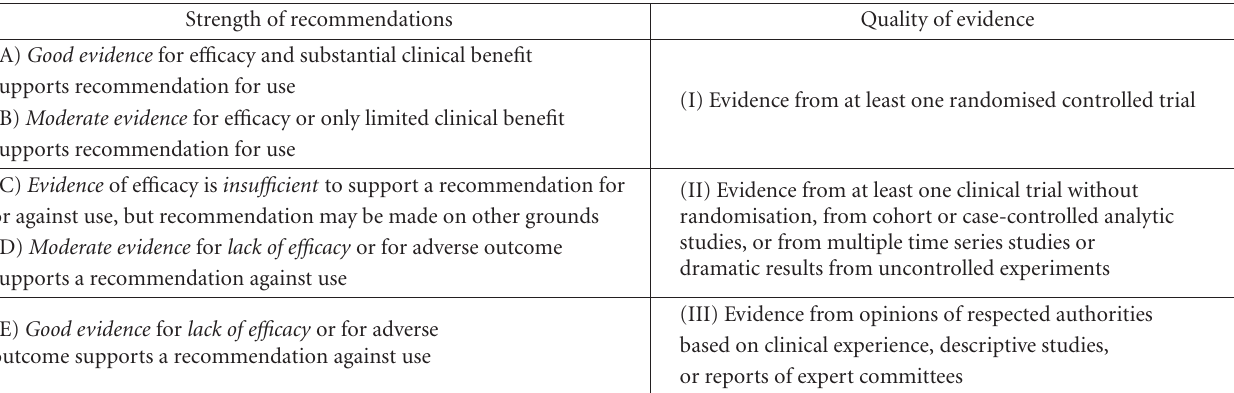
Table 6: Coding systems used in reviewing